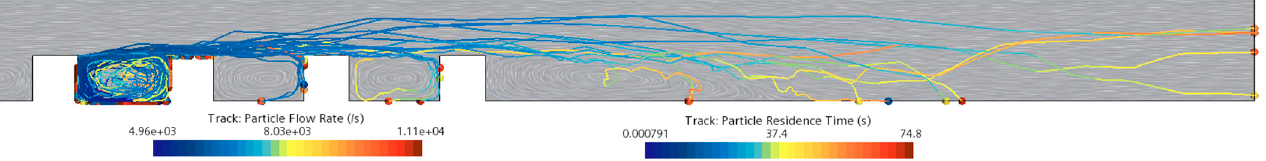
Figure 5. Particle dispersion and deposition in the computational domain (H/W = 0.5, u ref = 12.5 m/s). The points on the surface represent the deposited particles and the lines represent the particle tracks.